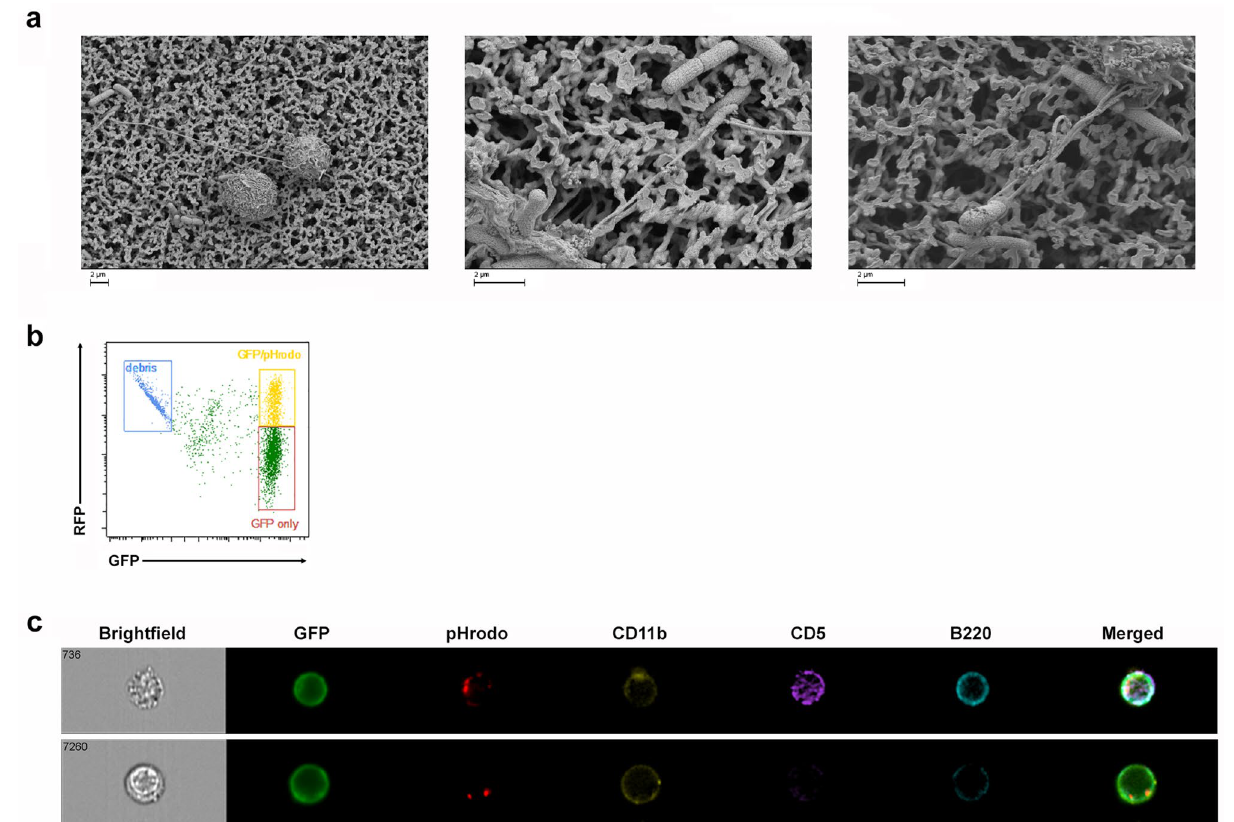
Figure 3. Renin-lineage peritoneal cells physically interact with bacteria and phagocytose bacteria particles. ( a ) Renin-lineage cells were incubated with 042 E. Coli bacteria for 2 h and then processed for scanning electron microscopy. Renin-lineage B-1 cells associate with bacteria through cable-like extensions. ( b ) A representative flow cytometry plot demonstrating GFP + cells (renin lineage cells) which are double positive for pHrodo. ( c ) Identification of renin lineage peritoneal cells that phagocytosed E. Coli particles using an ImageStreamX Mark II system. The ImageStream system software (IDEAS) obtained images of events determined to be GFP + cells that have phagocytosed pHrodo. The top panel shows an image of a renin-lineage B-1a B cell which has phagocytosed E. Coli particles (pHrodo + ). This cell expressed CD11b, CD5, and B220. The bottom panel shows an image of a renin-lineage B-1b cell